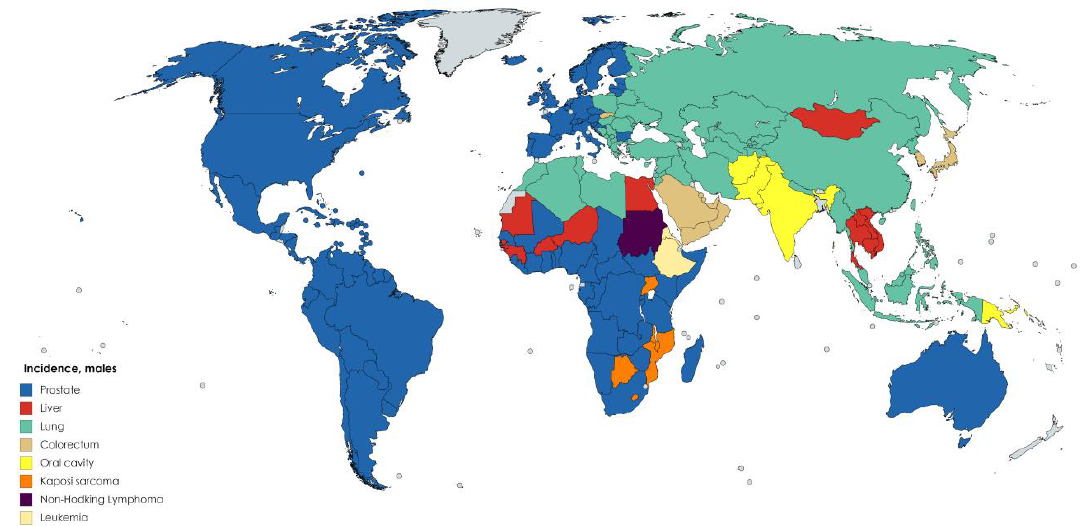
Figure 6. Worldwide cancer incidence by type in males [2]. Created with mapchart.net.